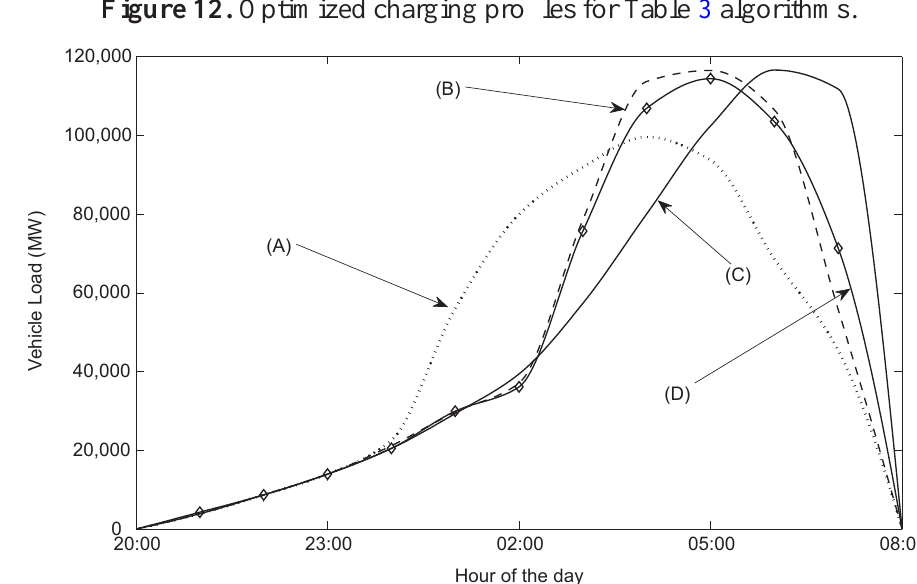
Figure 12. Optimized charging profiles for Table 3